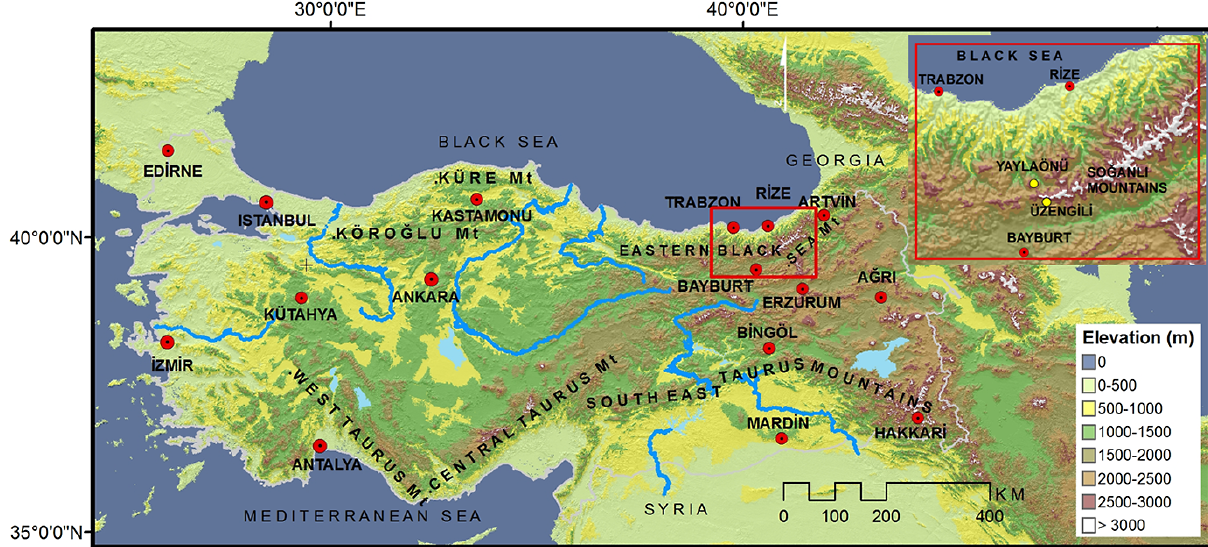
Fig. 1. Physical map of Turkey showing the most important mountain ranges and study areas (upper right corner).